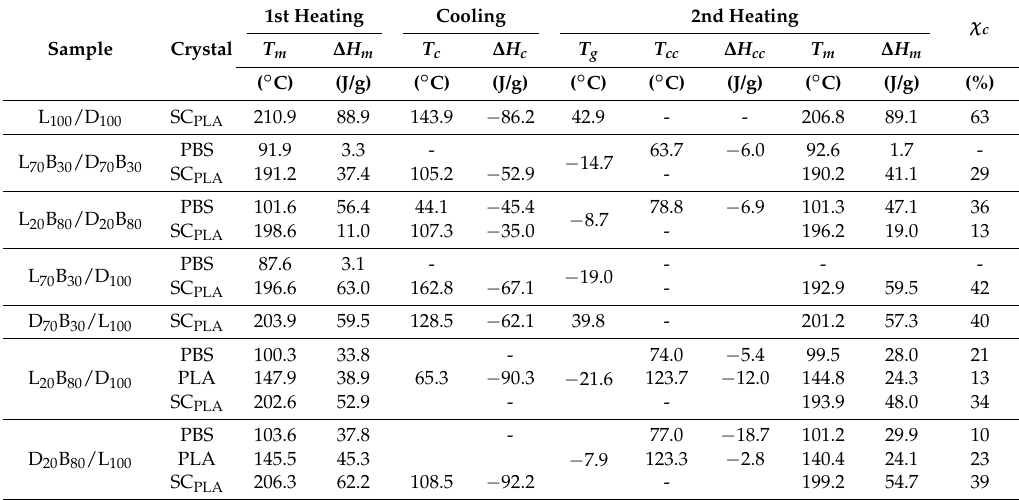
Figure 5. Glass transition temperature ( T g ) versus PLA content (XPLA) for different homopolymers, copolymers and copolymer/homopolymer blends. The solid line represents the fitting to the Fox equation. Table 5. Enthalpy of fusion, glass transition, and melting temperature of PLA stereocomplexes during the first heating, cooling, and second heating at 20 ◦